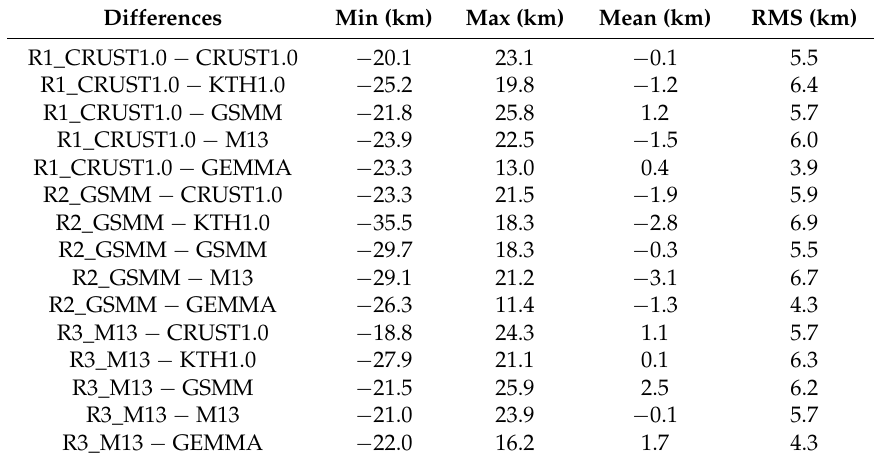
Table 6. Statistics of the Moho depth